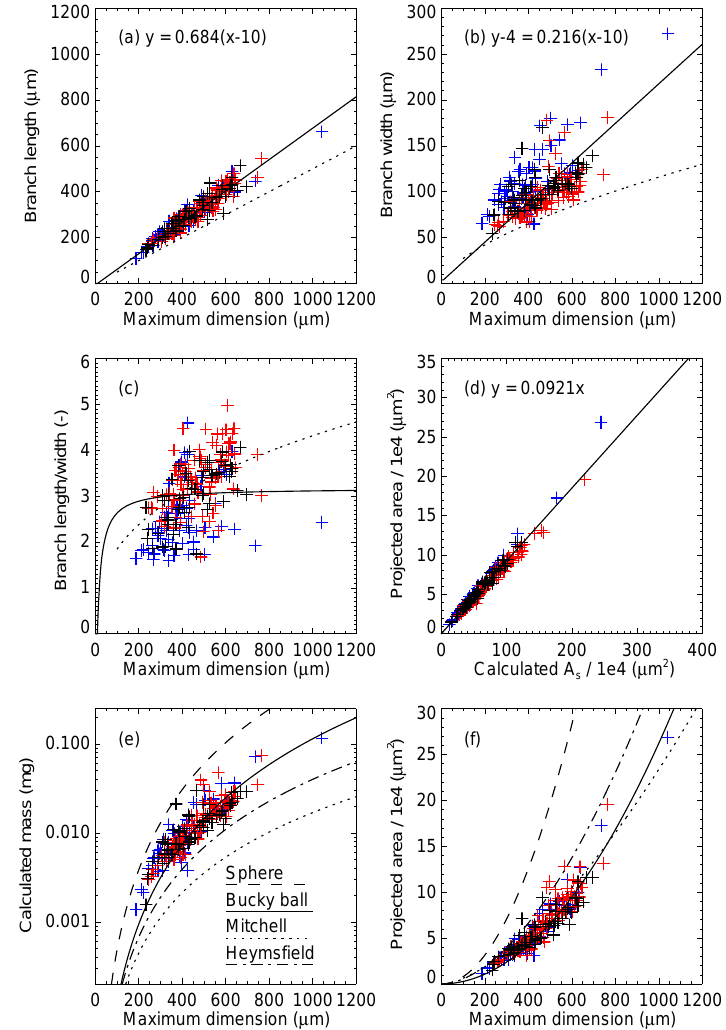
Figure 6. As in Fig. 4 except for Bucky ball model (see Sect. 4.2 and Appendix